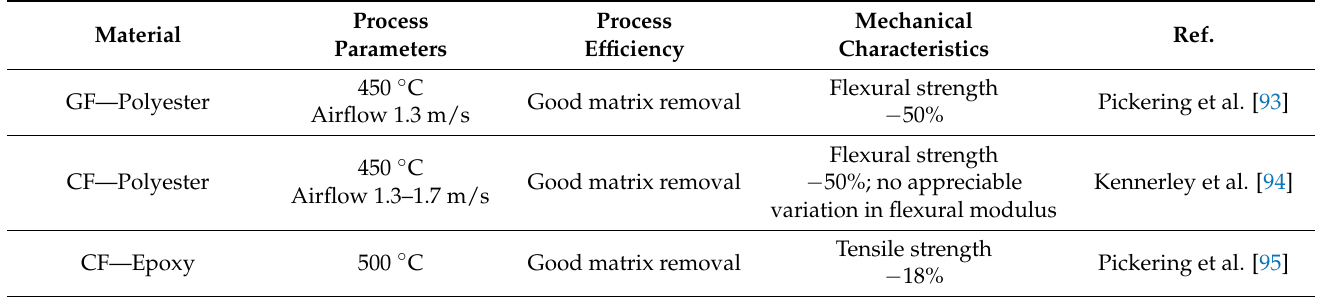
Table 5. Main results deriving from the thermal recycling process of fluidised